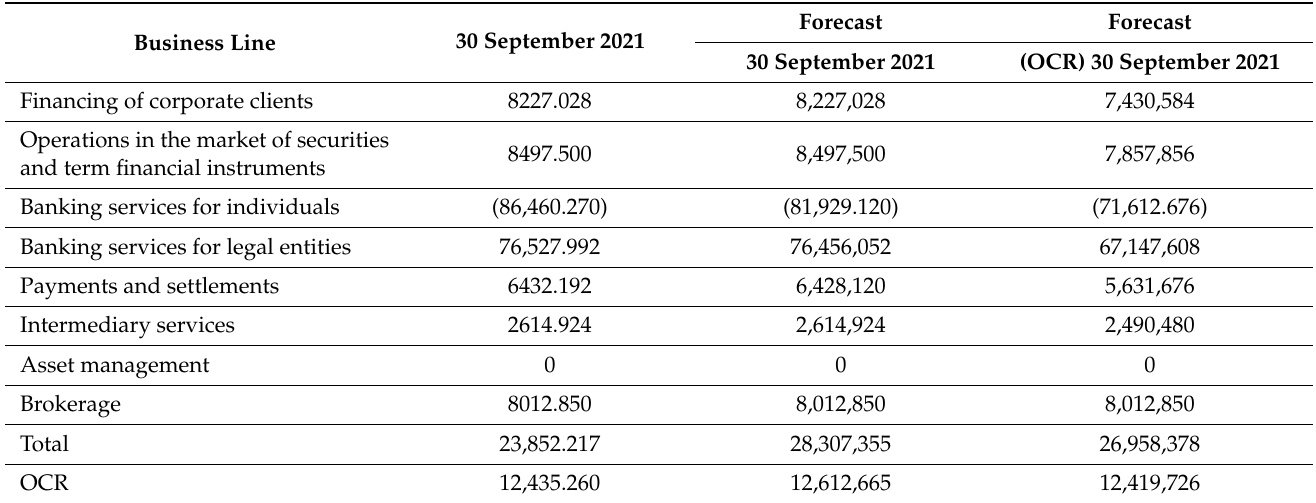
Table 7. Bank profits with initial data and with forecast